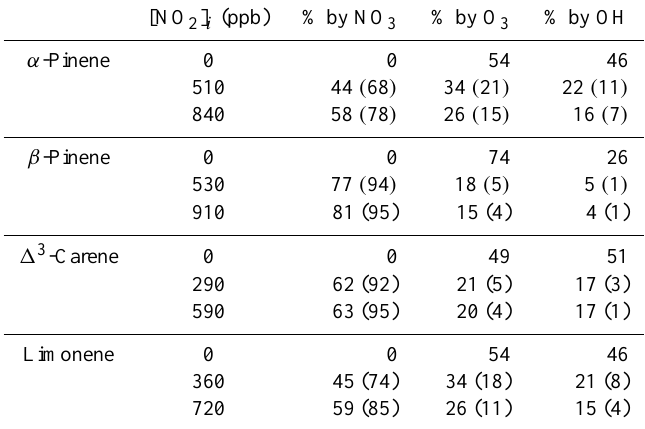
Table 3. Percentage of total BVOC reacted by each oxidant at 2h into each experiment. In the model, OH is produced from stabilized Criegee intermediates from ozonolysis at the following ratios: α -pinene = 0.85; β -pinene = 0.35; (cid:49) 3 -carene = 1.06; limonene = 0.86 (Atkinson et al., 1992). Values from NO 2 -containing experiments include two values expressed as low/high where “low” denotes the lower